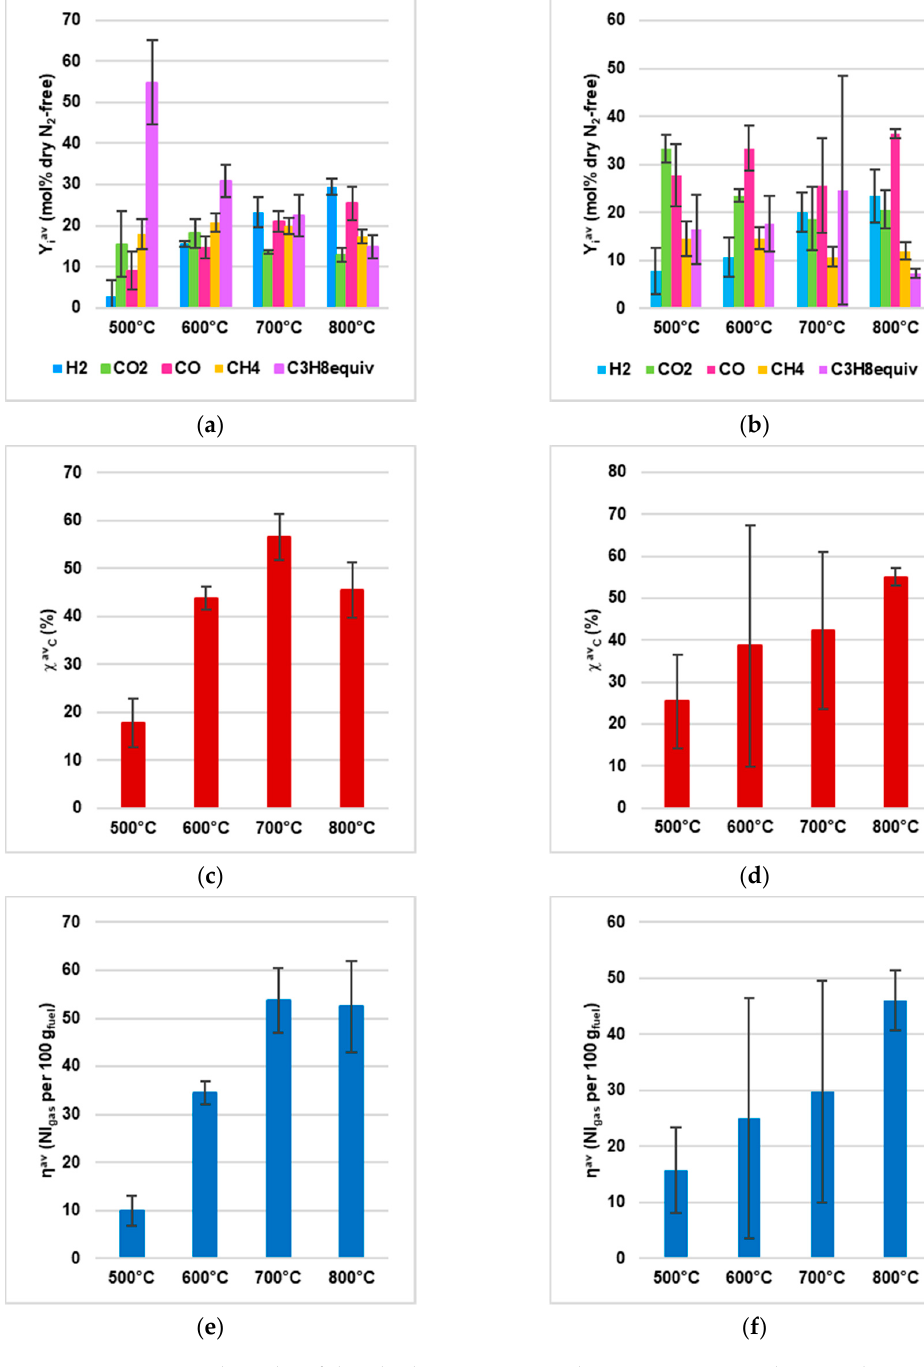
Figure 6. Experimental results of devolatilization tests under nitrogen atmosphere, in the sand fluidized bed, as functions of temperature: integral-average mol% dry, dilution-free ( Y iav , Equation (2)) of AHPam ( a ) AHPus ( b ); integral-average carbon conversion ( χ av C , Equation (3)) of AHPam ( c ) AHPus ( d ); integral-average gas yield ( η av , Equation (1)) of AHPam ( e ) AHPus ( f ); colored bars represent average values out of the three repetitions for each set “material kind/fluidizing agent/bed temperature”, errors bars quantify the related standard